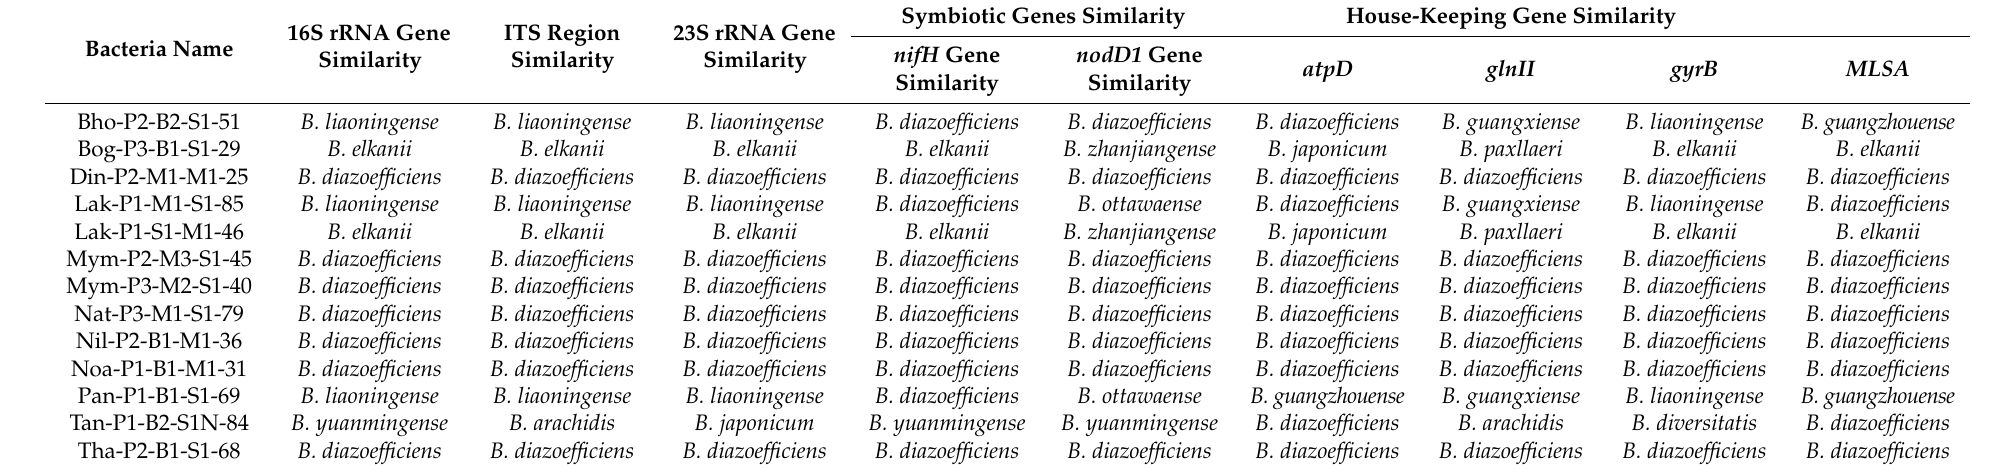
Table 5. Highest similarity of genes sequences of selected isolates with type